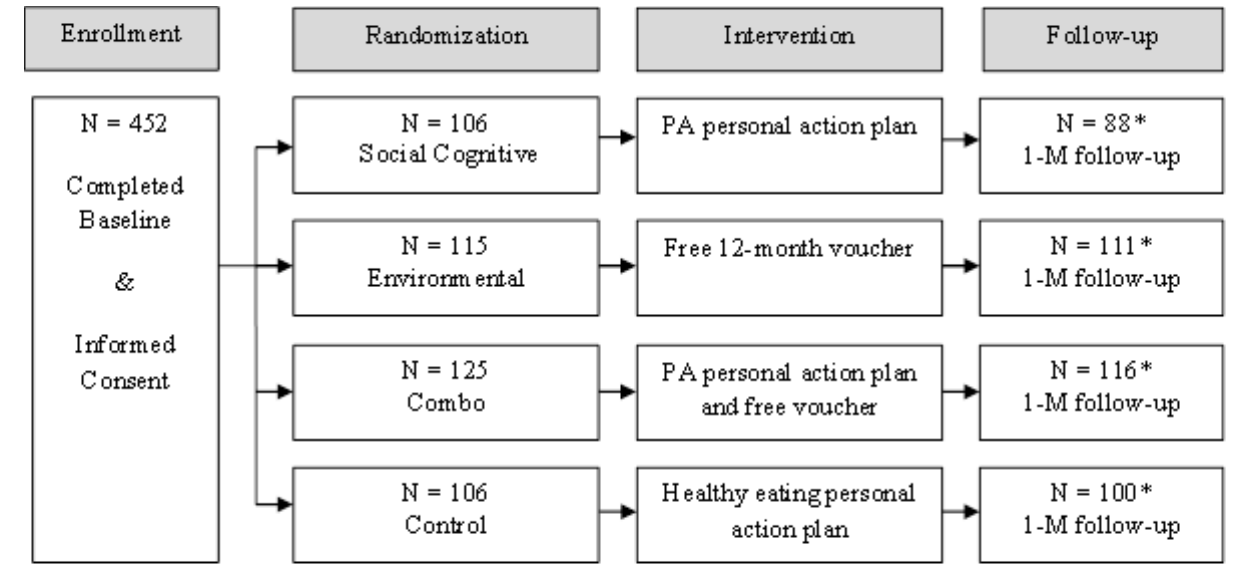
Figure 1. Flow diagram of participants’progress through